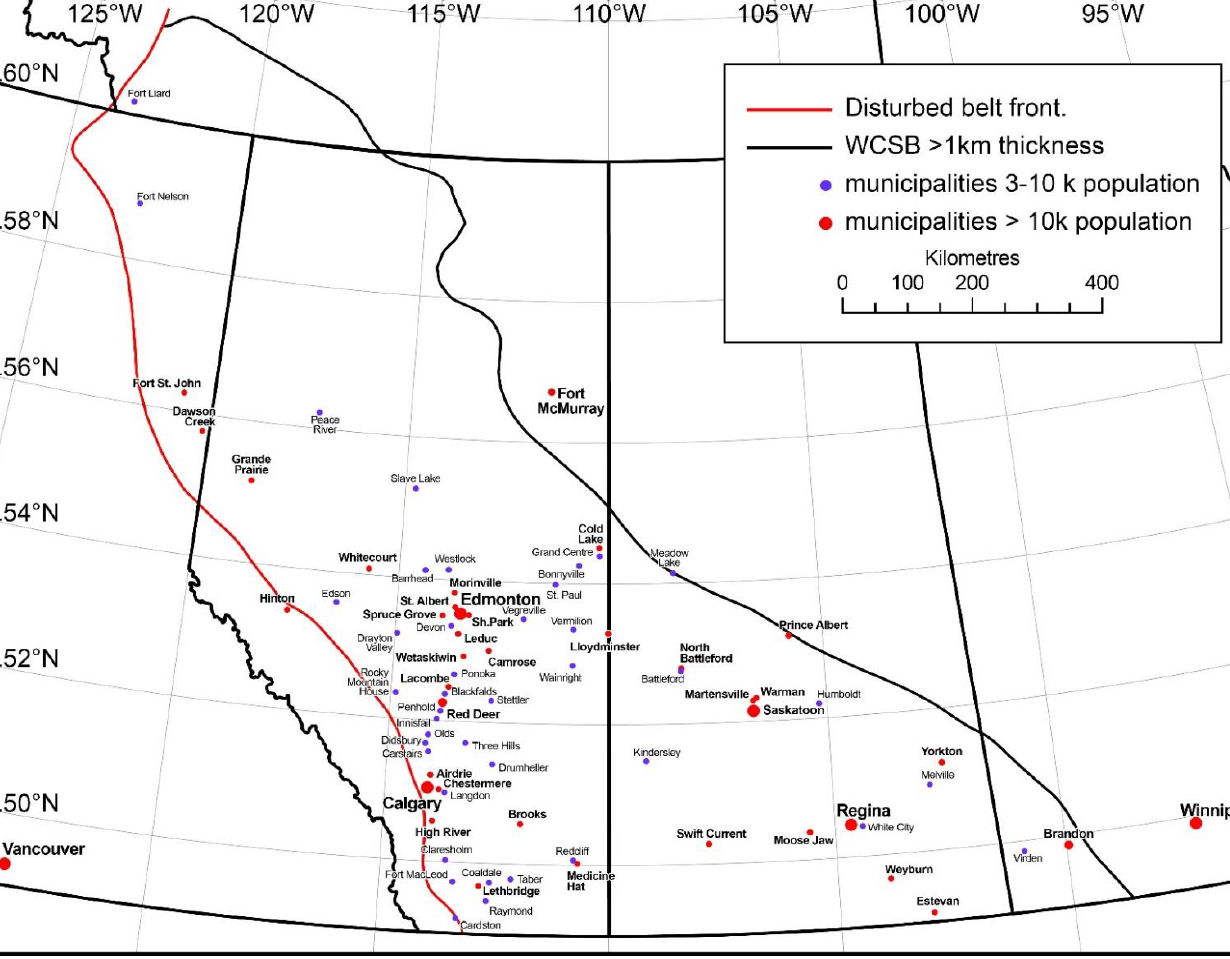
Figure 2. Location map of the Western Canadian Sedimentary Basin (WCSB) with provincial boundaries and locations of municipalities with populations >3k. The red line depicts the western margin of the WCSB defined by the deformation front of the Canadian Rocky Mountains.